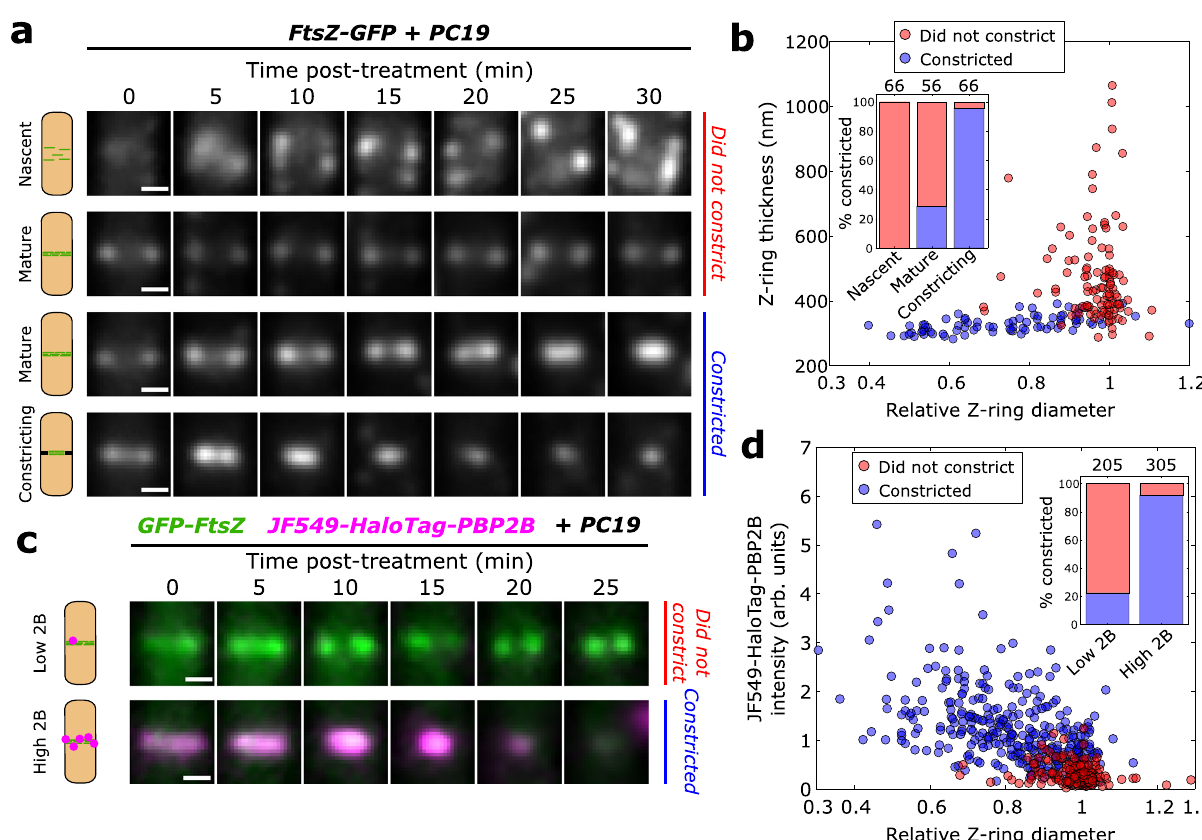
Fig. 3 FtsZ treadmilling is required until the arrival of PG synthesis machinery. a Representative time-lapses of Z-rings for FtsZ-GFP cells (SH130) after arrival of 10 μ M PC19-laced media. Nascent rings and many mature rings do not constrict for tens of minutes after PC19 treatment, whereas constricting rings and many mature rings continue constricting after treatment. b Scatter plot of Z-ring diameters and thicknesses for all FtsZ-GFP cells at t = 0 min showing whether they continued constricting (blue) or not (red). Inset: Percentage of cells that continued constricting classi fi ed by division stage. Nascent: thickness >400 nm, mature: thickness <400nm, relative diameter >0.9, constricting: thickness <400 nm, relative diameter <0.9. c Representative time- lapses of rings from two-colour strain SH212 (Green: GFP-FtsZ, magenta: JF549-HaloTag-PBP2B) after the arrival of PC19-laced media. Z-rings with low JF549-HaloTag-PBP2B signal typically do not continue constricting while those with high signal typically do. d Scatter plot of Z-ring diameters and normalised JF549-HaloTag-PBP2B intensities at t = 0 min showing whether they continued constricting (blue) or not (red). Inset: Percentage of cells that continued constricting classi fi ed by JF549-HaloTag-PBP2B signal. Low 2B: intensity <0.5, High 2B: intensity >0.5. Scale bars: 500 nm. Numbers above stacked bars indicate number of cells. Source data for this fi gure are provided as a source data fi